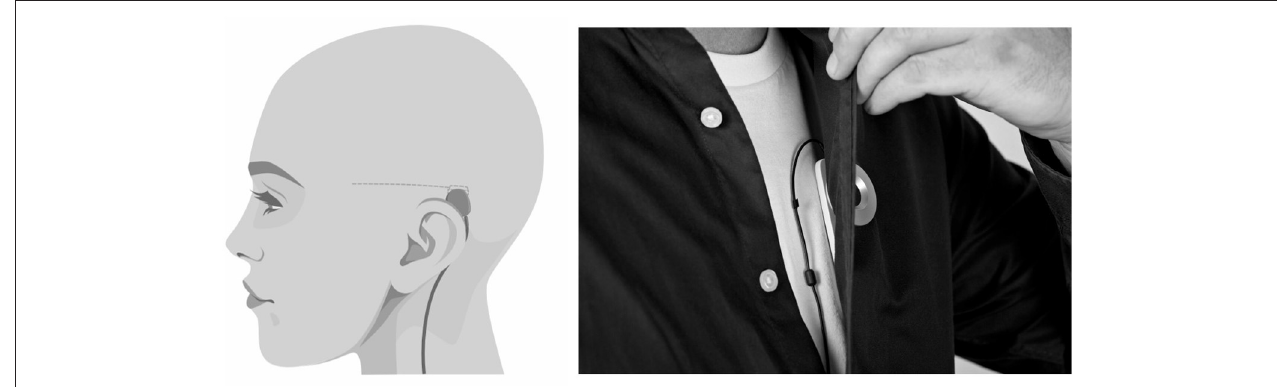
FIGURE 1 | The SubQ solution and its placement in this study. Left : sagittal view of the head showing the placement of implant at the temporal region, recording 2-channel bipolar temporal sqEEG. Right : frontal view of the trunk demonstrating the placement of the external device, recording 3-axis accelerometry of the body